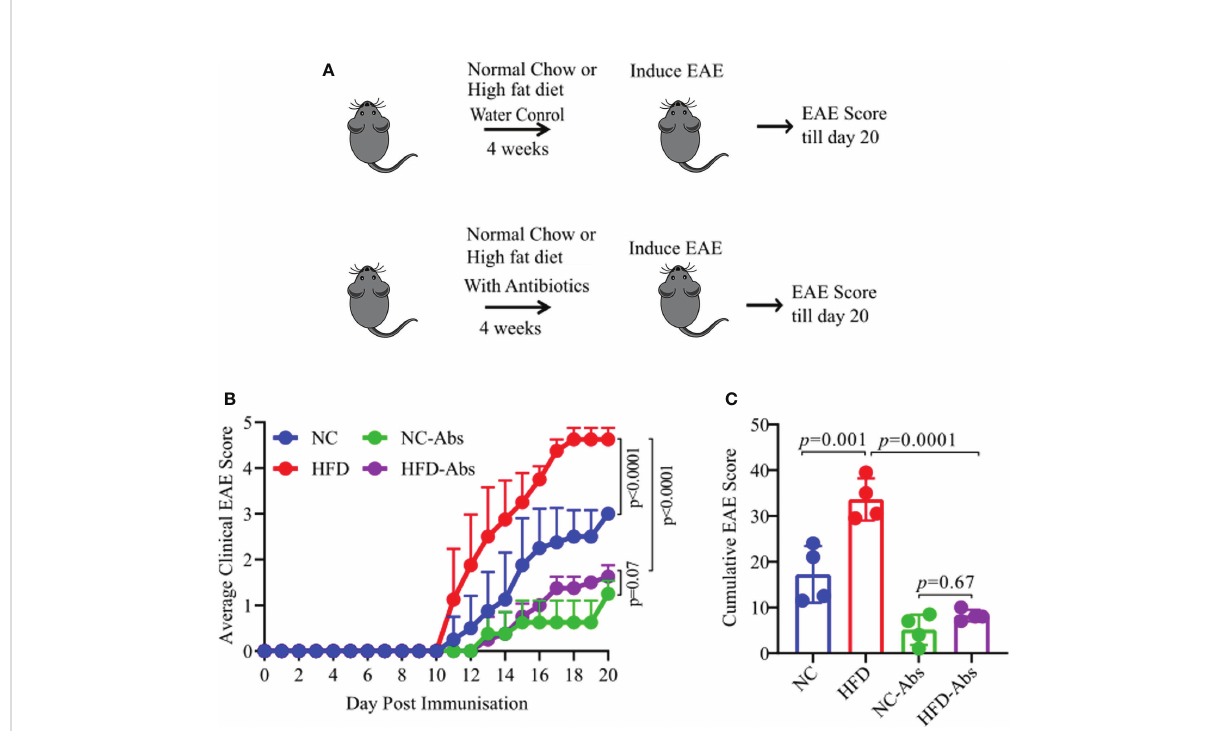
FIGURE 2 Gut bacteria depletion in HFD fed HLA-DR3 transgenic mice ameliorate EAE. (A) Model diagram representing day of diet initiation, antibiotics treatment, EAE induction and disease scoring in HLA-DR3 mice. 6-8-week-old male HLA-DR3 transgenic mice were placed on a HFD or a normal chow diet for 4 weeks while receiving broad spectrum antibiotics in the drinking water followed by immunization with PLP 91-110 /CFA to induce EAE. (B) Comparison of mean clinical scores in mice fed a HFD or normal chow diet and while receiving broad spectrum antibiotics in the drinking water. (C) Cumulative EAE scores from mice as in (A) . Data are representative of 4 mice per group. Error bars represent the standard error of the mean for each experimental group. p -value was determined by 2way ANOVA test (B, C)